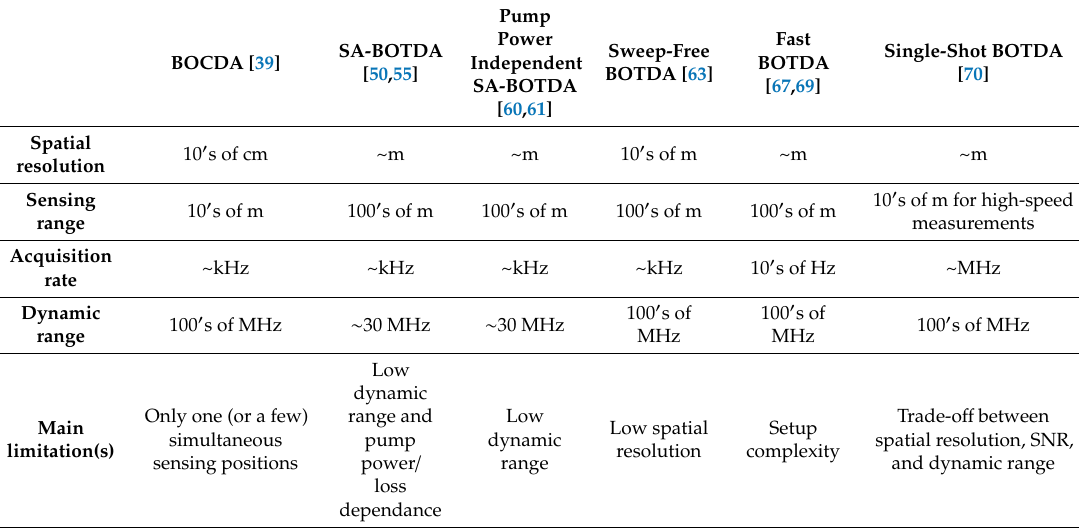
Table 1. Summary of the main performance of fast Brillouin sensing